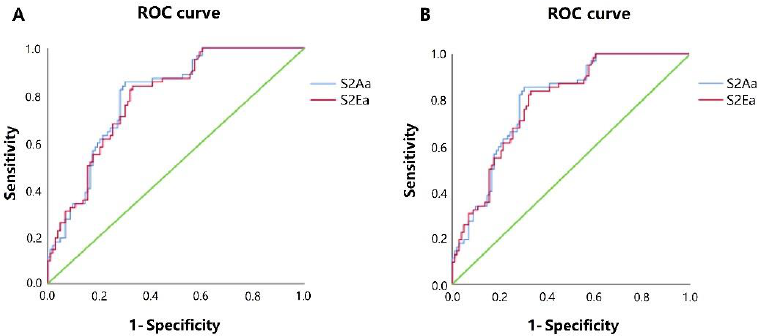
Figure 7. ( A ) ROC curve analysis showed that the sensitivity and specificity of S2Aa ≤ 251.5 mv for the diagnosis of SBP < 90 mmHg were 0.968% and 0.417%, respectively, and the sensitivity and specificity of S2Ea ≤ 243 for the diagnosis of SBP < 90 mmHg were 0.984% and 0.408%, respectively. The AUC was 0.795 for S2Aa and 0.788 for S2Ea. ( B ) ROC curve analysis showed that the sensitivity and specificity of S2Aa ≤ 204.5mv for the diagnosis of MAP < 60 mmHg were 0.930% and 0.354%, respectively, and the sensitivity and specificity of S2Ea ≤ 182 for the diagnosis of MAP < 60 mmHg were 0.942% and 0.354%, respectively. The AUC was 0.705 for S2Aa and 0.707 for S2Ea. ROC: receiver operating characteristic curve; AUC: area under the